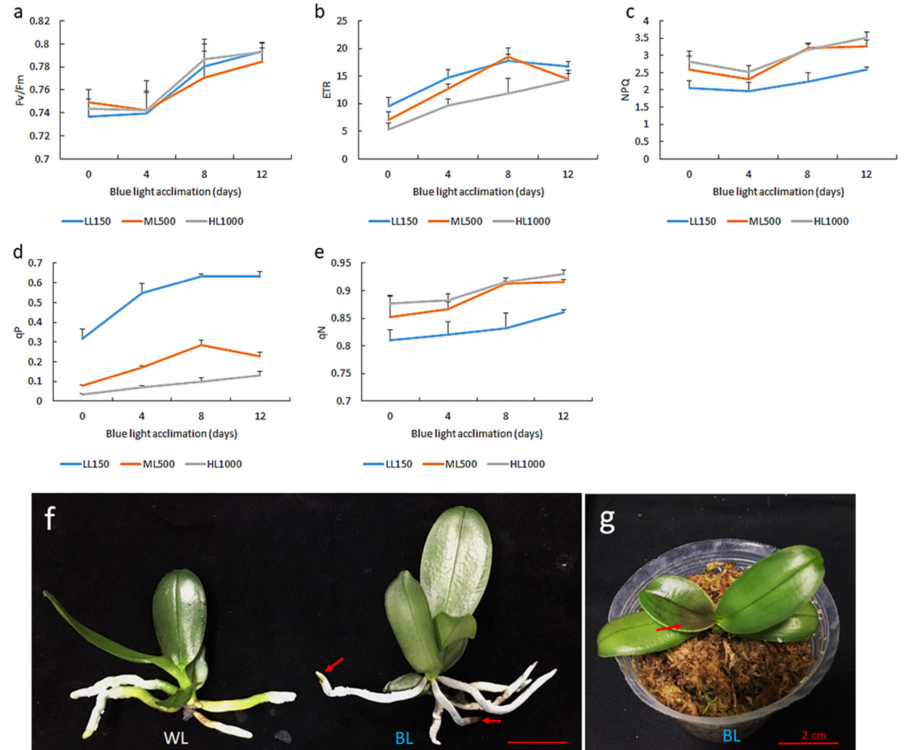
Figure 2. Time course of blue light acclimation to improve the chlorophyll fluorescence of Phalaenopsis seedlings. Young tissue culture seedlings were transplanted into a sphagnum moss 1.7” pot for a one-month establishment time and were then exposed to BL for 0, 4, 8 and 12 days, respectively. ( a – e ) The detection of chlorophyll fluorescence parameters, including Fv / Fm, electron transport rate (ETR), non-photochemical quenching (NPQ), photochemical quenching of fluorescence (qP) and non-photochemical quenching of fluorescence (qN), was measured by setting a fluorescence leaf-chamber light intensity at 150 (LL), 500 (ML) and 1000 µ mol m − 2 s − 1 (HL), respectively. After BL treatment at 100 µ mol m − 2 s − 1 for 12 days, anthocyanin accumulated in the ( f ) root tip and ( g ) young leaves of the orchid. Red arrows indicate the sites of anthocyanin